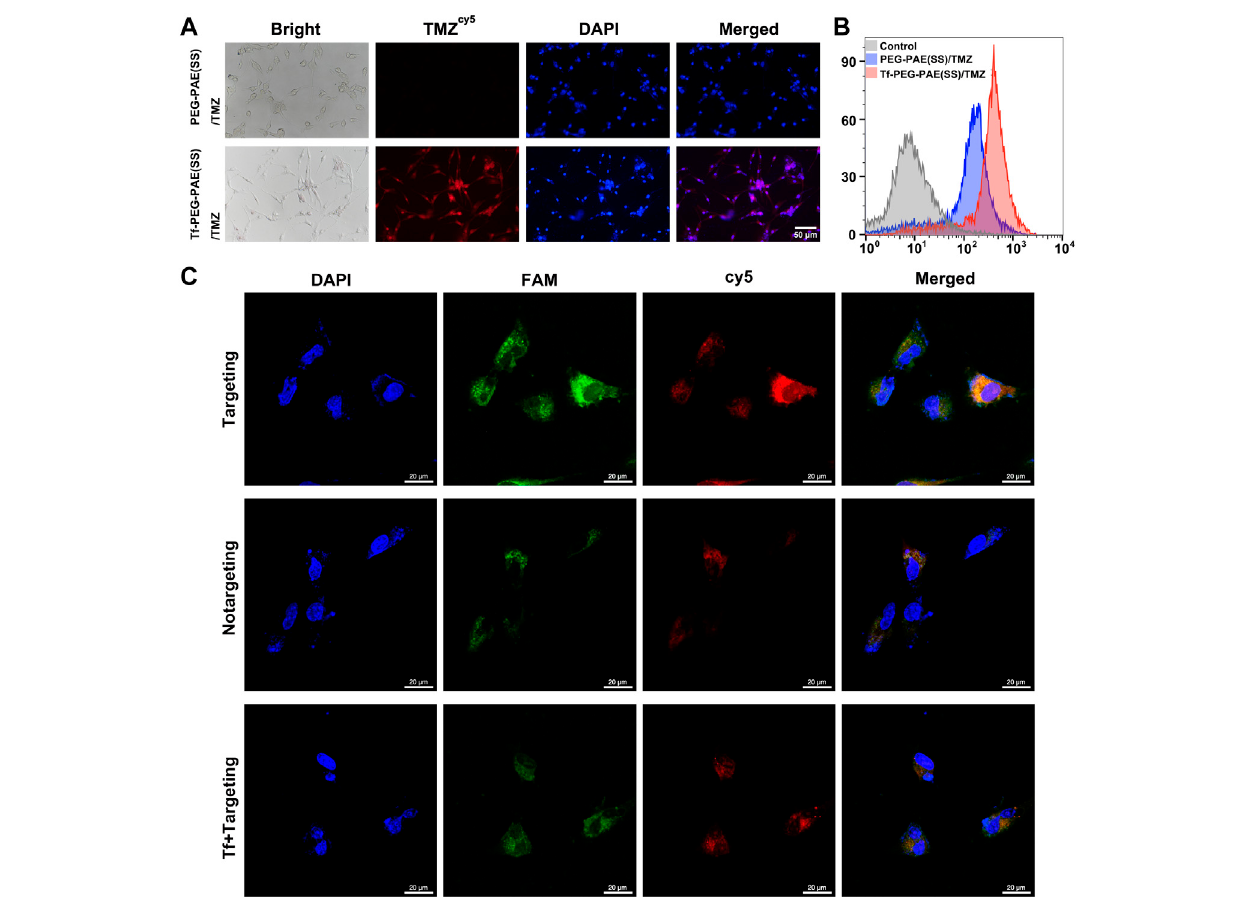
FIGURE 4 | (A) Intracellular release of TMZ cy5 from PEG-PAE(SS)/TMZ cy5 and Tf-PEG-PAE(SS)/TMZ cy5 , Scale bar: 50 μ m. (B) Drug fl uorescence of PEG-PAE (SS)/TMZ cy5 andTf-PEG-PAE(SS)/TMZ cy5 incellswasanalyzedby fl owcytometry. (C) CLSMimagesofU87cellsincubatedwithTf-PEG-PAE(SS)/TMZ cy5 @siEGFR FAM (targeting), PEG-PAE(SS)/TMZ cy5 @siEGFR FAM (nontargeting), and Tf-PEG-PAE(SS)/TMZ cy5 @siEGFR FAM with 2 mg/l Tf (Tf + targeting). Blue, green, red, and orange fl uorescence indicate DAPI (nuclei), FAM (siEGFR), Cy5 (TMZ), and the overlapping of FAM and Cy5, respectively. Scale bar: 20 μ